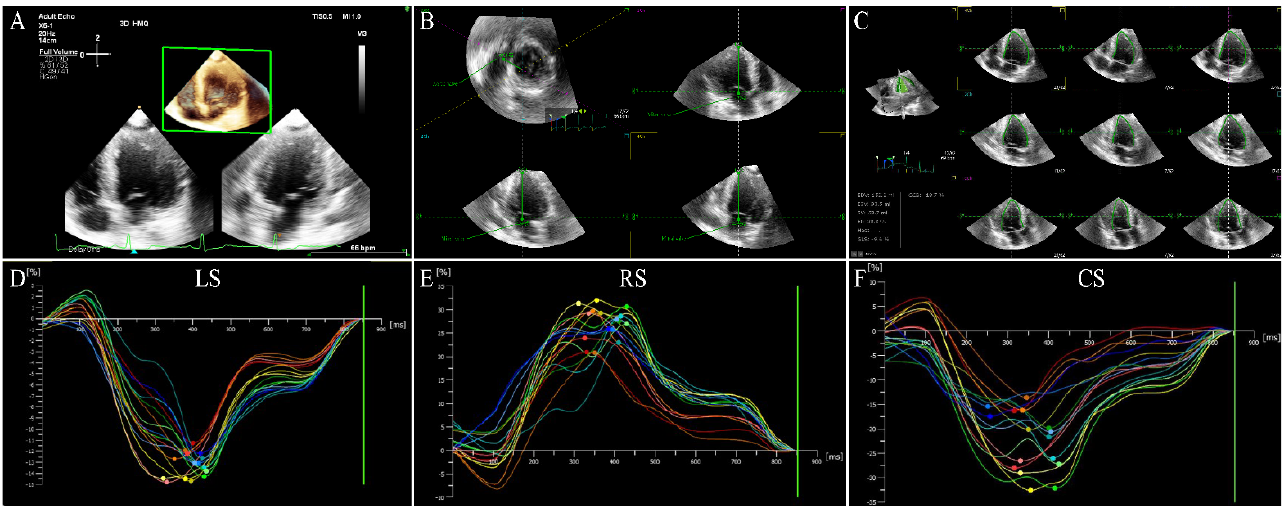
Figure 1. LV three − dimensional strain images in a HFrEF patient. ( A ) Three-dimensional image of LV − focused apical 4 − chamber view. ( B ) Reference points setting. ( C ) LV endocardial border identification and tracking. ( D − F ) Longitudinal, radial, and circumferential strain of left ventricle. LV: left ventricular; LS: longitudinal strain; RS: radial strain; CS: circumferential strain; HFrEF: heart failure with reduced ejection